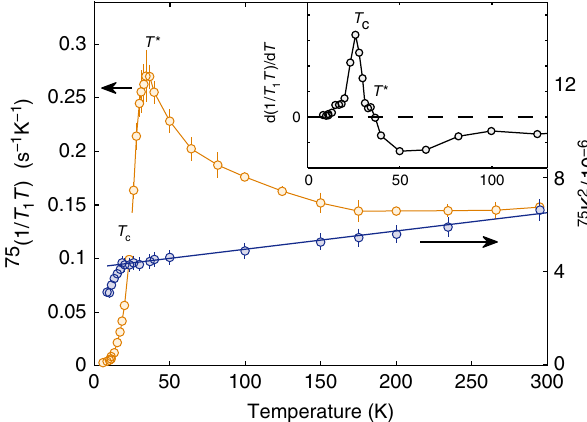
Fig. 5 Different temperature behavior of 1/( T 1 T ) and K 2 . Temperature dependence of 1/( T 1 T ) ( left scale) and 75 K 2 shift ( right scale) measured at 7 T. The peak in the former and the drop in the latter indicate T * and T c , respectively, which differ by ca. 5 K. The clearly different functional form of the two curves below ca. 150 K indicates the development of strong AF fl uctuations. The strong low-temperature drop of 1/( T 1 T ) con fi rms the bulk character of SC, whereas the peak in the derivative (inset) indicates its sharp onset